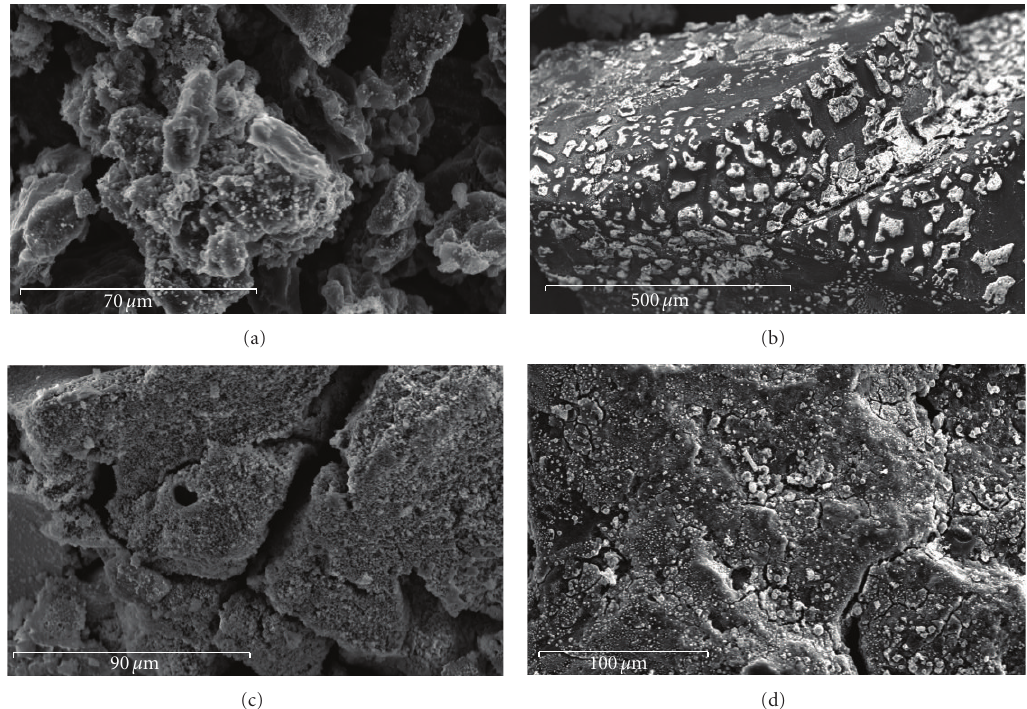
Figure 3: SEM images of iron coated (a) MN-1, (b) MN-2, (c) MN-3, and (d)